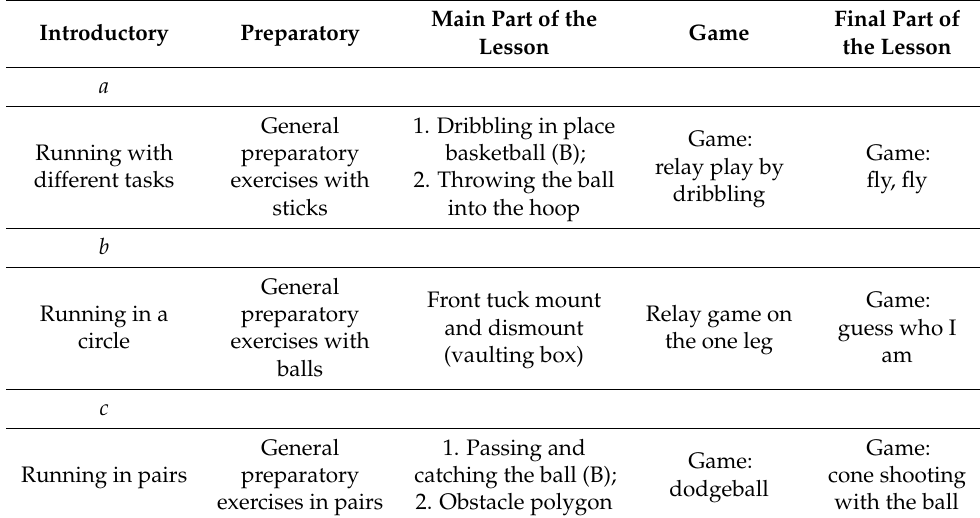
Table 1. Microcycle: example of the program content for three lessons per week.